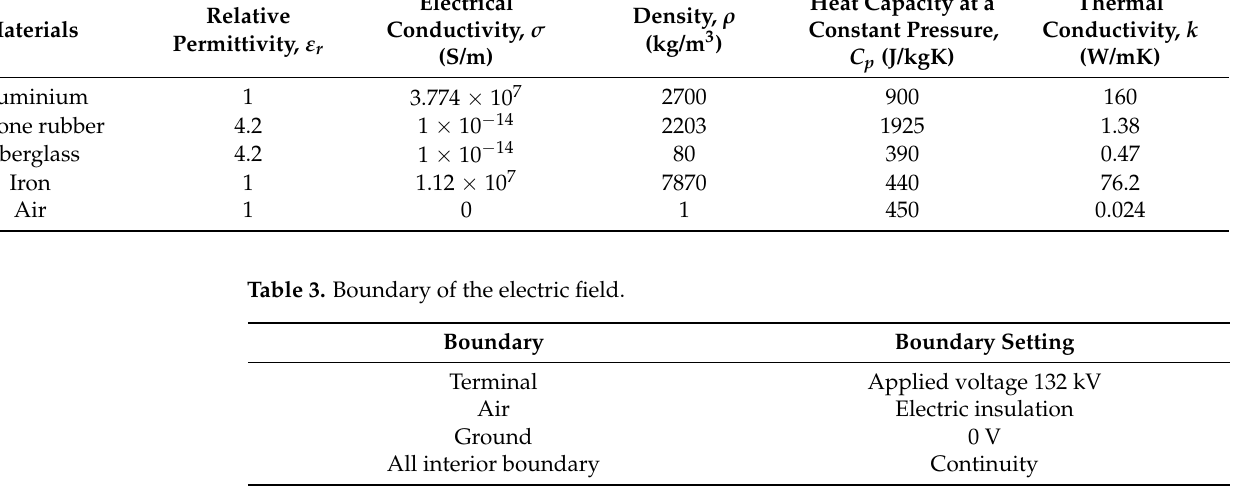
Table 3. Boundary of the electric field .